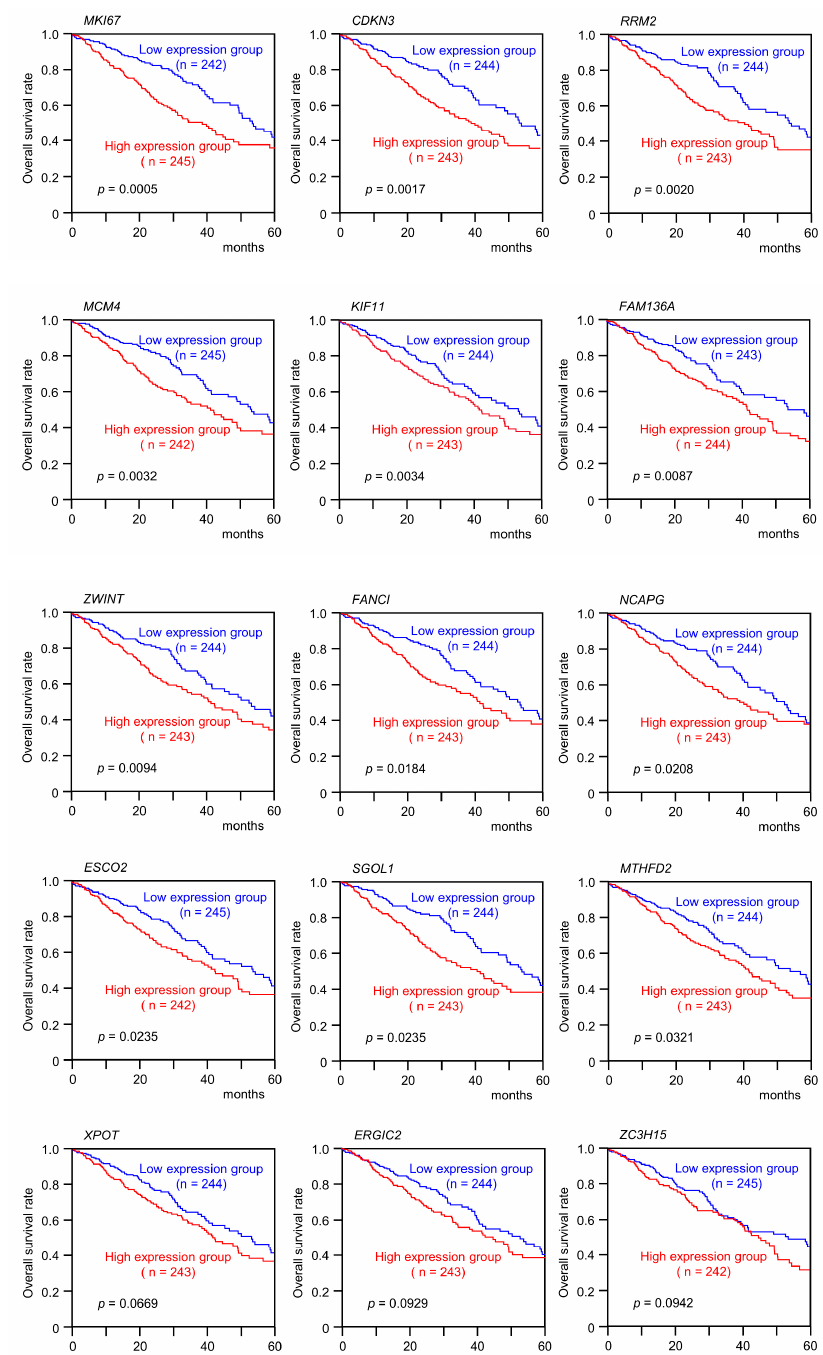
Figure 5. Clinical significance of pre- miR-99a target genes in TCGA database. Kaplan–Meier survival curves and log-rank comparisons of patients with LUAD using TCGA datasets. Patients were divided into two groups according to the median expression of each pre- miR-99a target gene evaluated: high and low expression groups. The red and blue lines represent the high and low expression groups, respectively. High expression mRNA of 18 genes ( CKS1B , KCMF1 , CENPF , CASC5 , MKI67 , ESCO2 , FANCI , SGOL1 , MCM4 , KIF11 , NEK2 , MTHFD2 , NCAPG , RRM2 , FAM136A , ZWINT , CDK1 and CDKN3 ) significantly predicted worse survival (5-year overall survival rate) in patients with LUAD. The expression data were downloaded from http: //